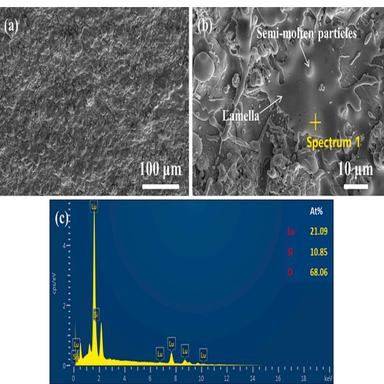
(a) Surface morphology of Lu2SiO5 coatings, (b) Enlarged image of (a), (c) EDS.